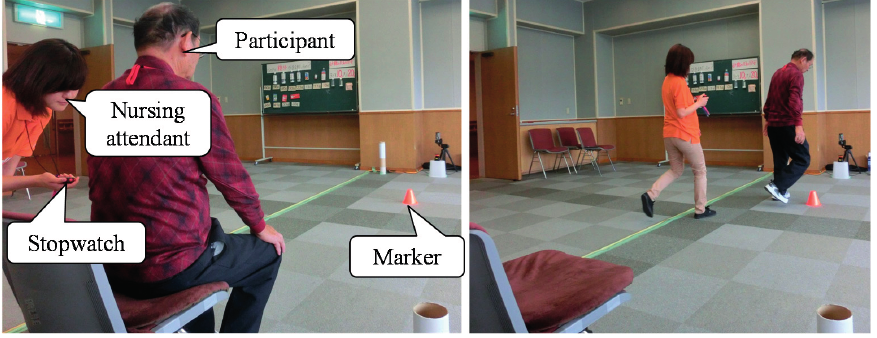
Figure 1. Appearance of the timed up and go test (TUG) measurement in actual community health